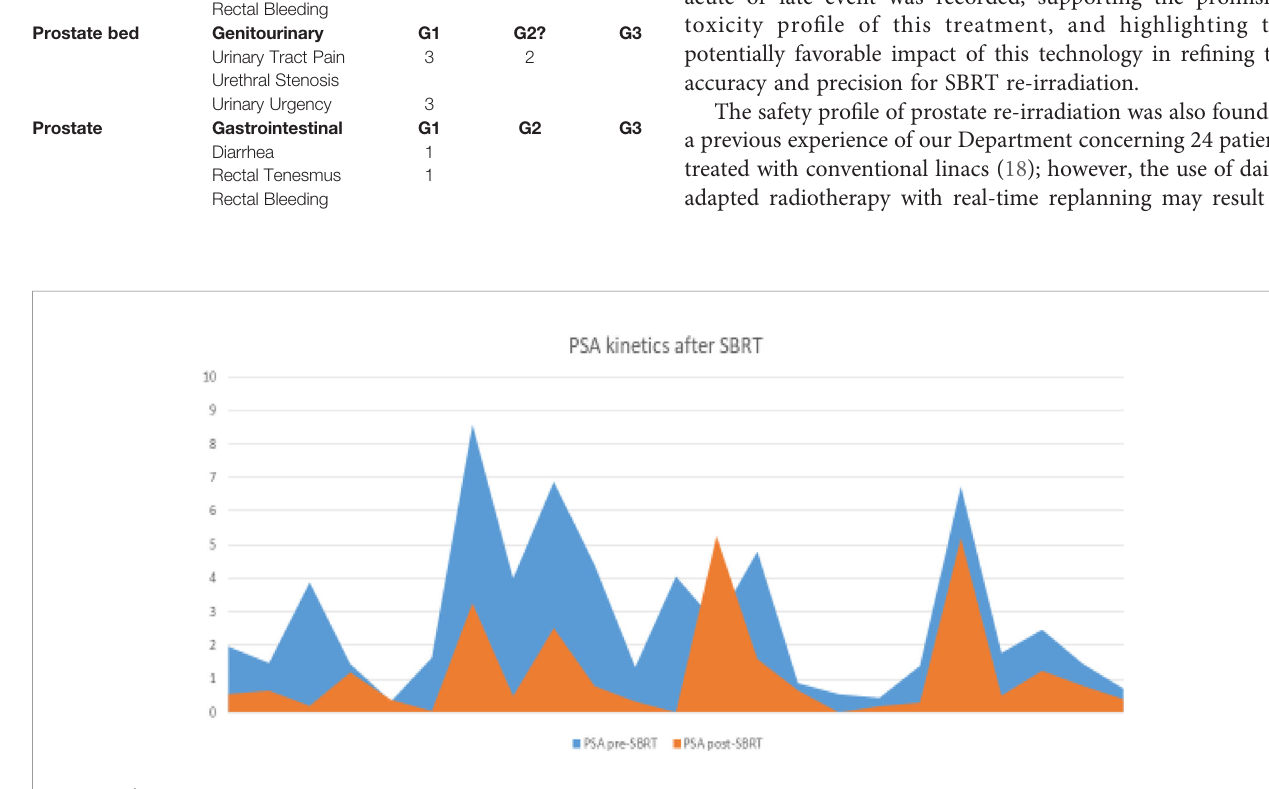
FIGURE 1 | PSA kinetics after